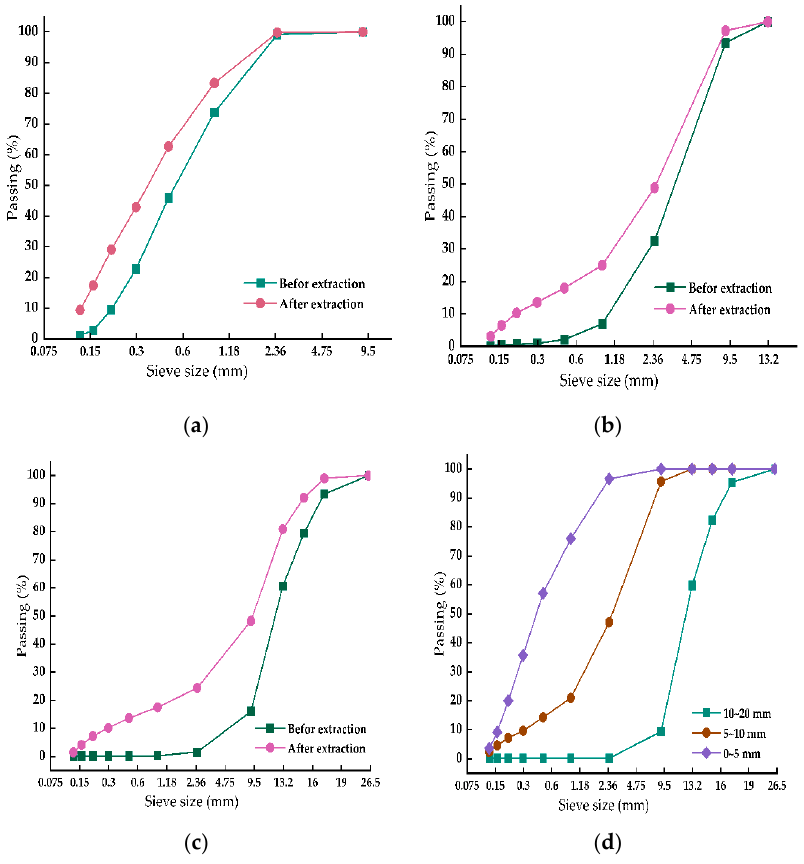
Figure 1. Particle size distribution of RAP and RAI materials. ( a ) RAP 0/5 (asphalt content 6.0%). ( b ) RAP 5/10 (asphalt content 4.0%). ( c ) RAP 10/20 (asphalt content 3.37%). ( d ) RAI.